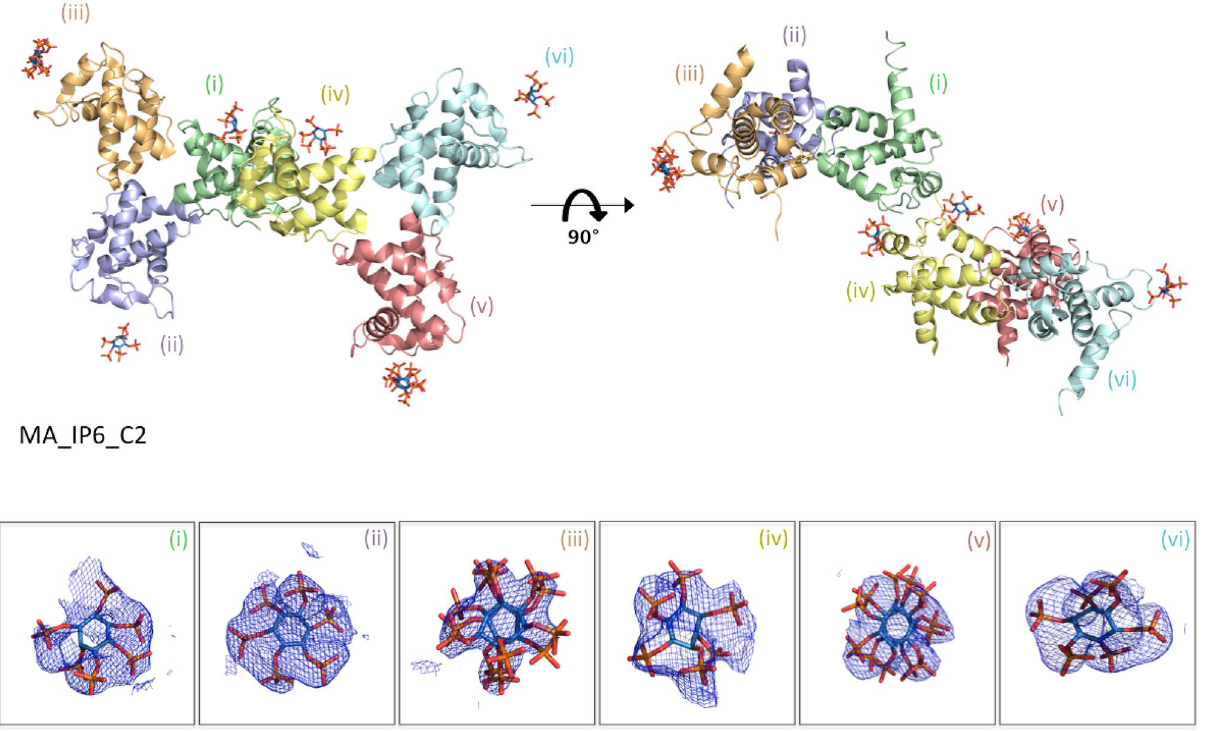
Figure 2. The overall structure of MA_IP6_C2 in an asymmetric unit. MA proteins in the asymmetric unit are shown by cartoon representation. Each chain is indicated by a different color and labeled with the respective color (pale green: chain ( i ), light blue: chain ( ii ), light orange: chain ( iii ), pale yellow: chain ( iv ), salmon: chain ( v ), pale-cyan: chain ( vi ). Carbon, oxygen and phosphorus atoms of IP6 are colored by sky-blue, red and orange, respectively. A 2 F o- F c simulated annealing-omit map colored in blue mesh at 2.5σ level within 5.0 Å from IP6 is shown. For better view density maps derived from IP6 molecules are enlarged and shown in the insets.